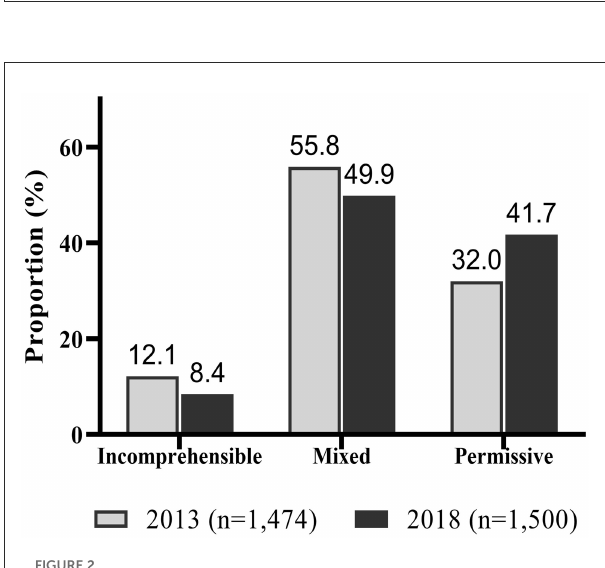
FIGURE2 Comparison of frequency of classified groups by survey year (2013,